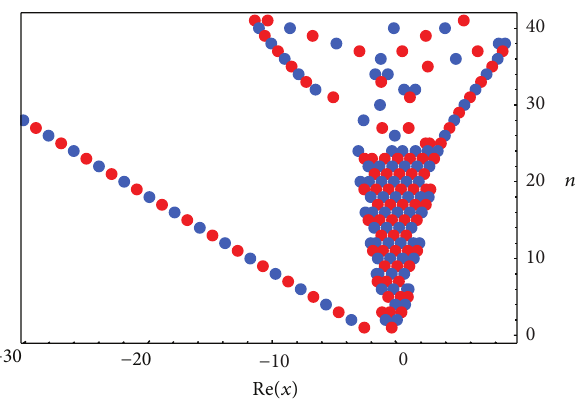
Figure 7: Real zeros of 𝐸 𝑞 (𝑠,𝑤) .